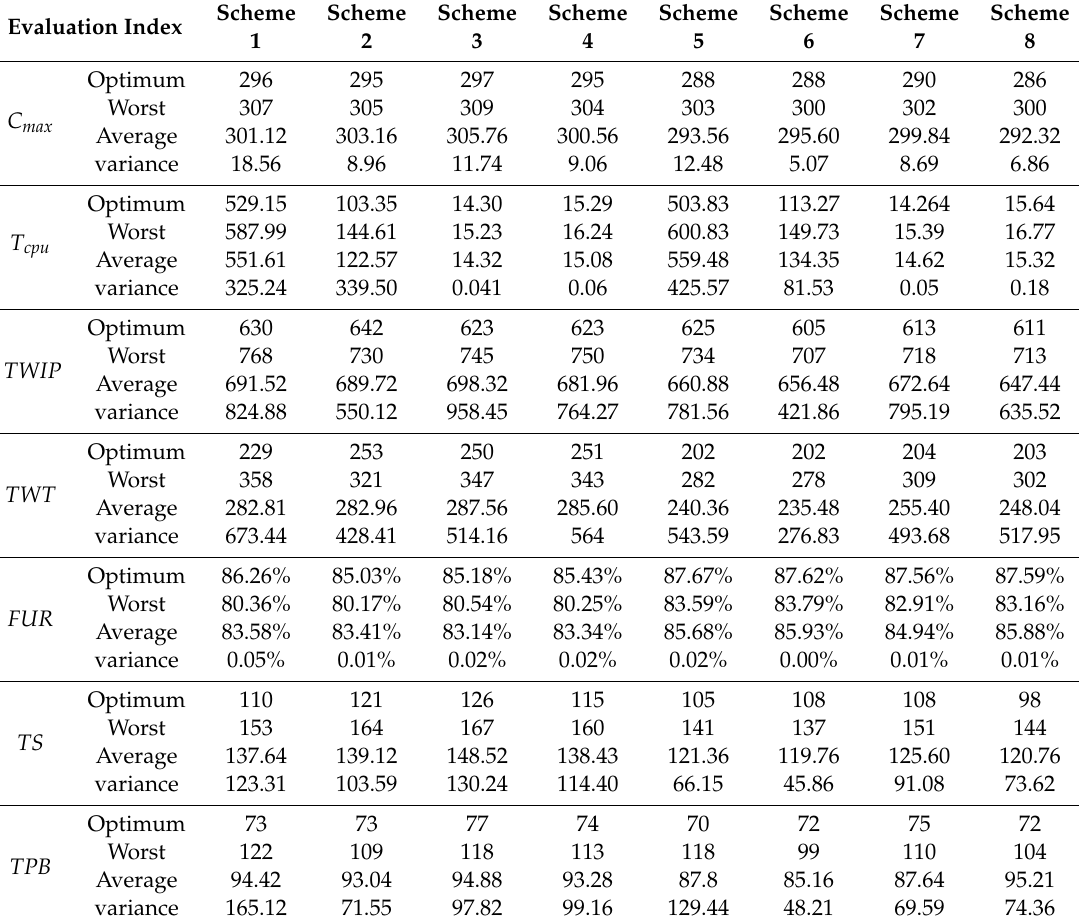
Table 8. Evaluation index comparison of scheduling results of eight